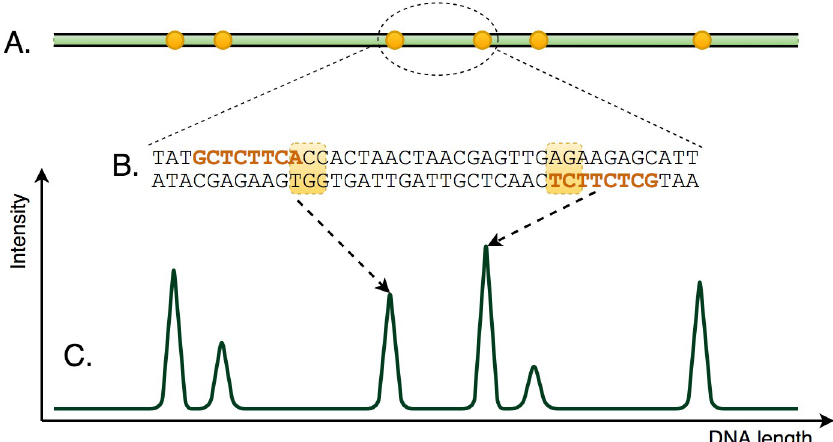
Fig 1. The principle of BNG optical mapping. Long DNA molecules (A) are fluorescently labelled at specific sites (B). Signals are then captured (C) in which peaks correspond to these sites.